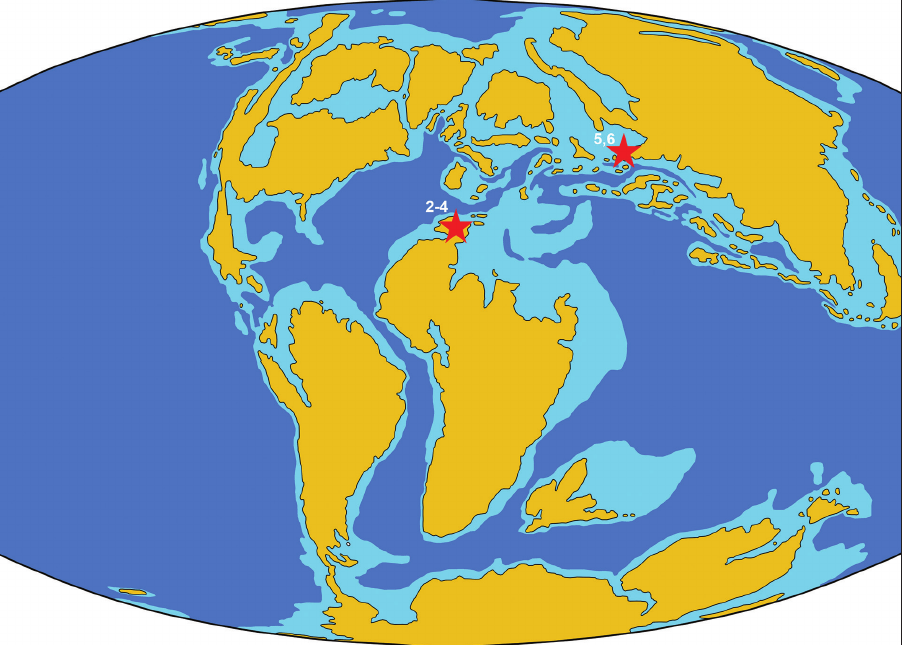
Figure 3. Paleogeographic map of the early Late Cretaceous (105 Ma) showing Cenomanian-age localities of azhdarchids. The numbers of localities correspond to the list in the text. The map is modified from http://